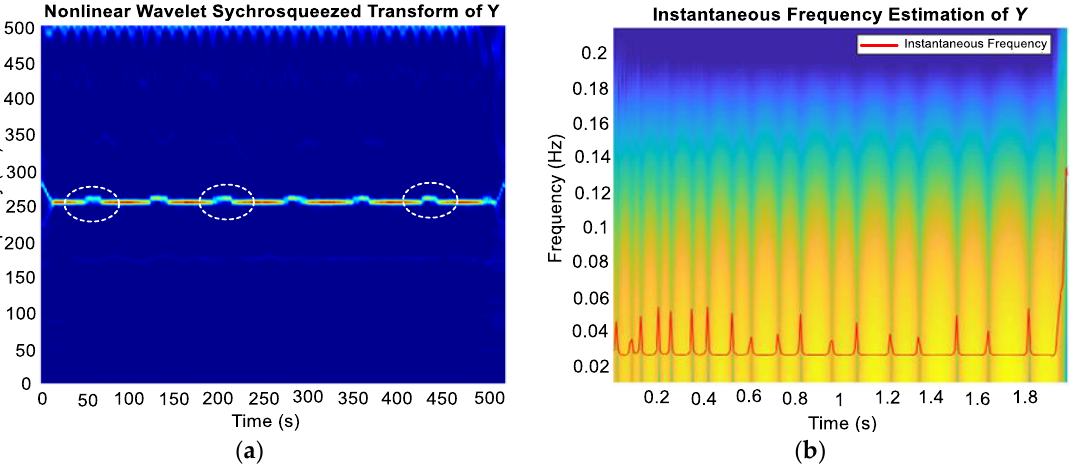
Figure 14. Friction/fluid-NWSST representation of the rotor-casing rubbing signal in an inviscid fluid. ( a ) Time-frequency ridges from NWSST; ( b ) Estimated IF amplitude spectrum of the signal.